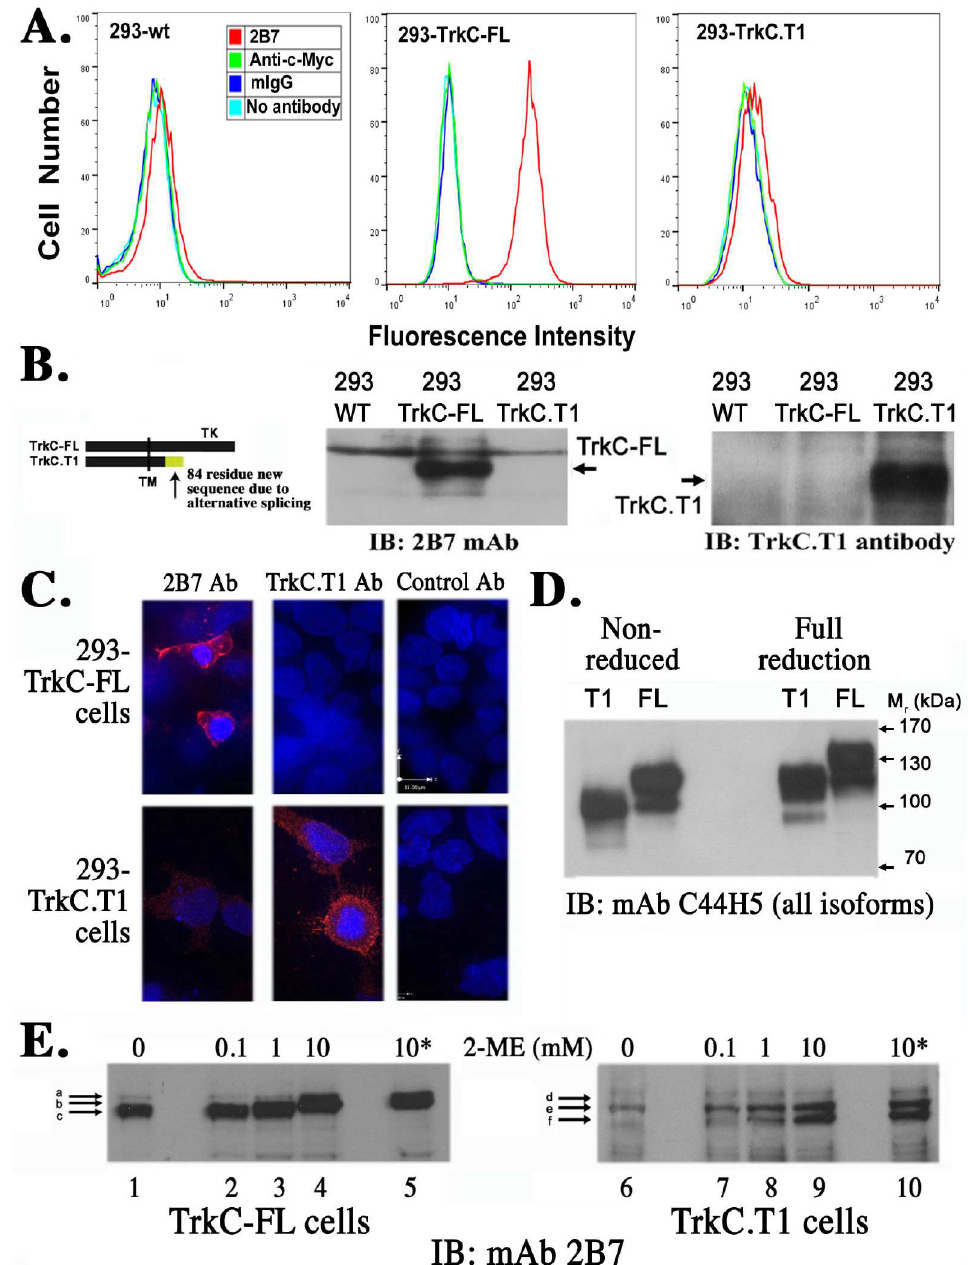
Fig 1. 2B7 mAb binds only to full length TrkC. (A) HEK293-TrkC-FL or HEK293-TrkC.T1 cells were studied by FACScan. HEK293 wild type cells are negative control. MAb 2B7 (red histograms) binds to cell surface TrkC-FL protein, at mean channel fluorescence ~300. Several isotype-matched controls are shown for background, all at mean channel fluorescence ~10. No significant bindingto the cell surface was detected using mAb 2B7 on NIH-TrkC.T1 cells, mean channelfluorescence~15. (B) Non-reducing western blots of HEK293-TrkC-FL or HEK293-TrkC.T1 cells. MAb 2B7 only recognizeslysates form TrkC-FL cells. A control antibody 750 (against an intracellularneo-epitopethat appearsdue to mRNA splicing)only recognizesTrkC. T1 and demonstrates that the cells express TrkC.T1 protein. (C) Fluorescent microscopy of 293-TrkC-FL or 293-TrkC.T1 cells immunostained with primary mAb 2B7, or antibody 750, or with non-bindingmouse IgG control (red). DAPI counterstain for nuclei. Pictures were taken using a Leica confocal microscope with 63x magnification. MAb 2B7 only recognizes full length TrkC, whereas antibody 750 only recognizesTrkC.T1. ( D ) Lysates were preparedfrom HEK293-TrkC-FL or HEK293-TrkC.T1 cells and split as equal samples.